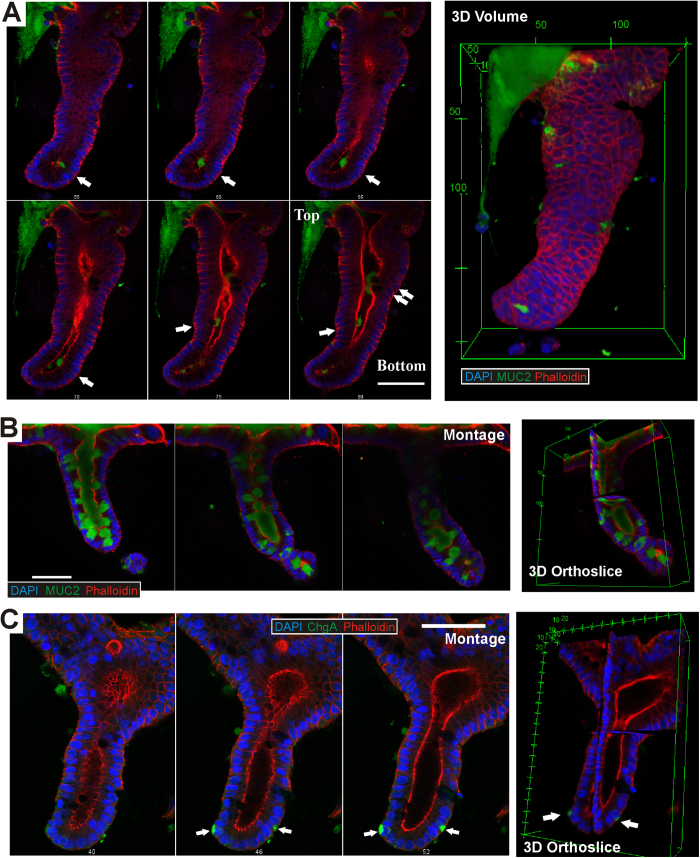
Mucin 2 and Chromogranin A expression in colonoids.Day 10 single-crypt and large-body colonoids were stained for DAPI (blue), Muc2 or ChgA (green) and F-actin (red). (A) The 2D montage showing the presence of various globlet cells along the length of the single-crypt colonoid with mucus secreting into the lumen (white arrows). 3D reconstruction of the colonoid (right panel) shows its similarity in shape to isolated crypts, with the top opening and crypt bottom clearly distinguishable. (B) 3D orthoslice view and 2D montage through the depth of a crypt budding off a large-body colonoid at day 10 stained for DAPI, Muc2 and F-actin are shown. The lumen and selected cells along the length of the crypt bud are filled with mucus. (C) 3D orthoslice views and 2D montage of a crypt budding off a large-body colonoid stained for DAPI, ChgA and F-actin, showing the presence of two ChgA positive cells in the bottom region of the colonoid crypt (arrows). Scale bars: 50 μm.